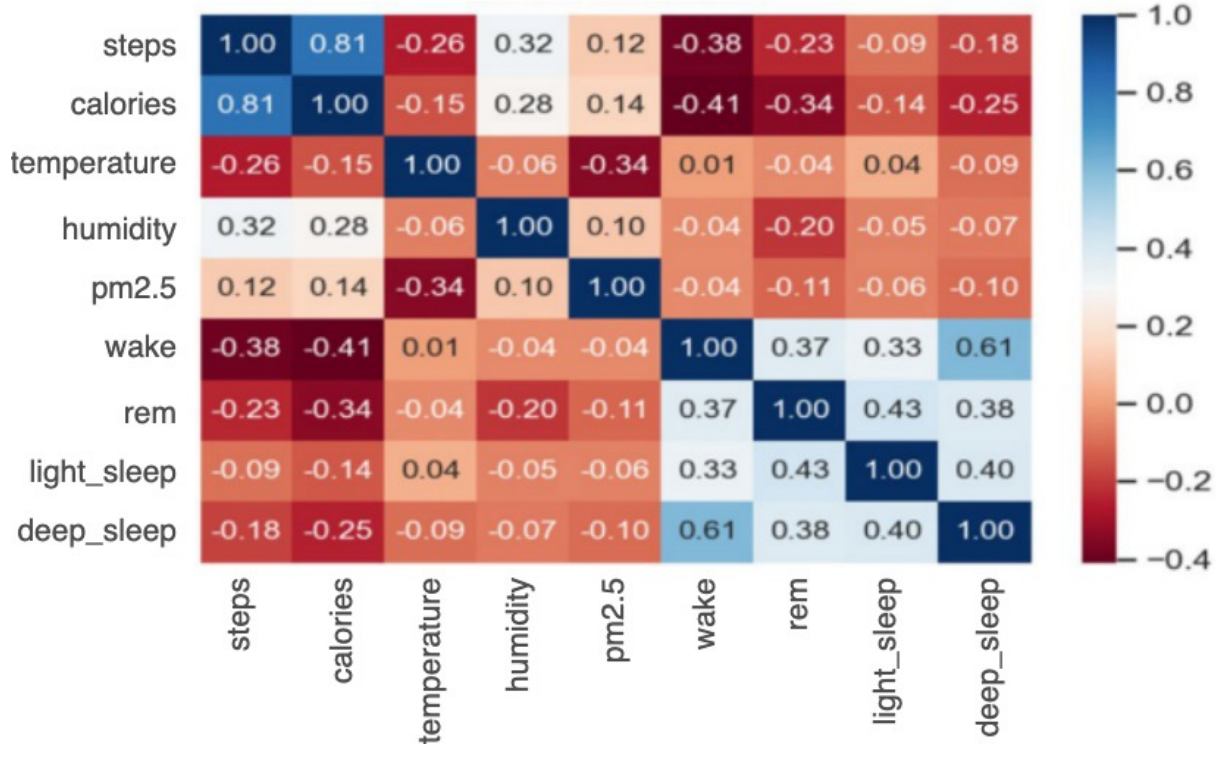
Figure 8. Correlation matrix of physiological and environmental